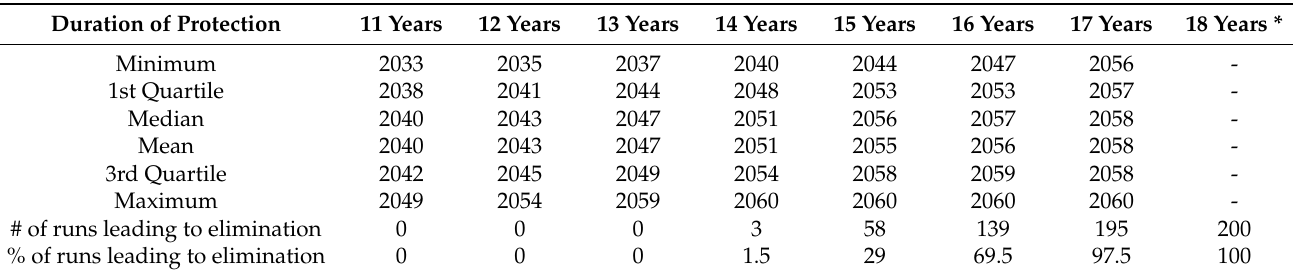
Table 3. Summary statistics showing the year disease incidence exceeds the threshold of 1 case per 100,000 population from 200 simulation runs for a range of values for the duration of protection. The scenario simulated to generate these results is the